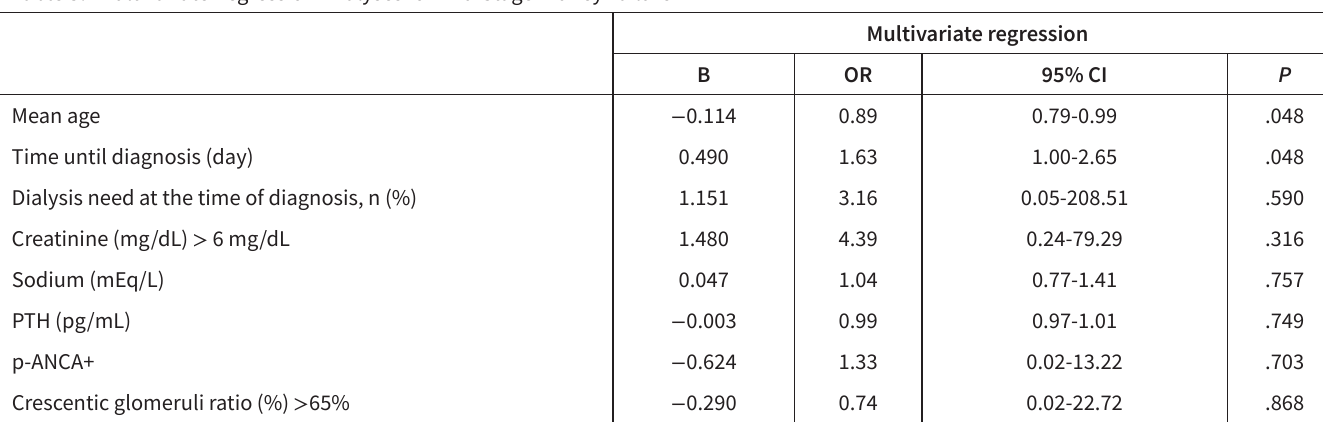
Table 5. Multivariate Regression Analyses for End-Stage Kidney Failure